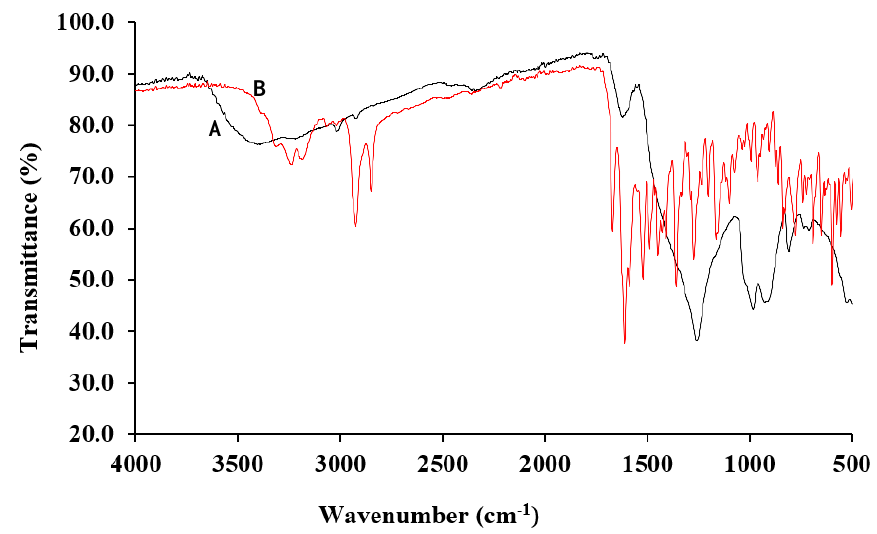
Figure 3. ATR–FTIR spectra of Hg 2+ –SE membrane: (A) membrane before being superimposed in Hg 2+ –SE and (B) the membrane after using for sensing Hg 2+ ions.